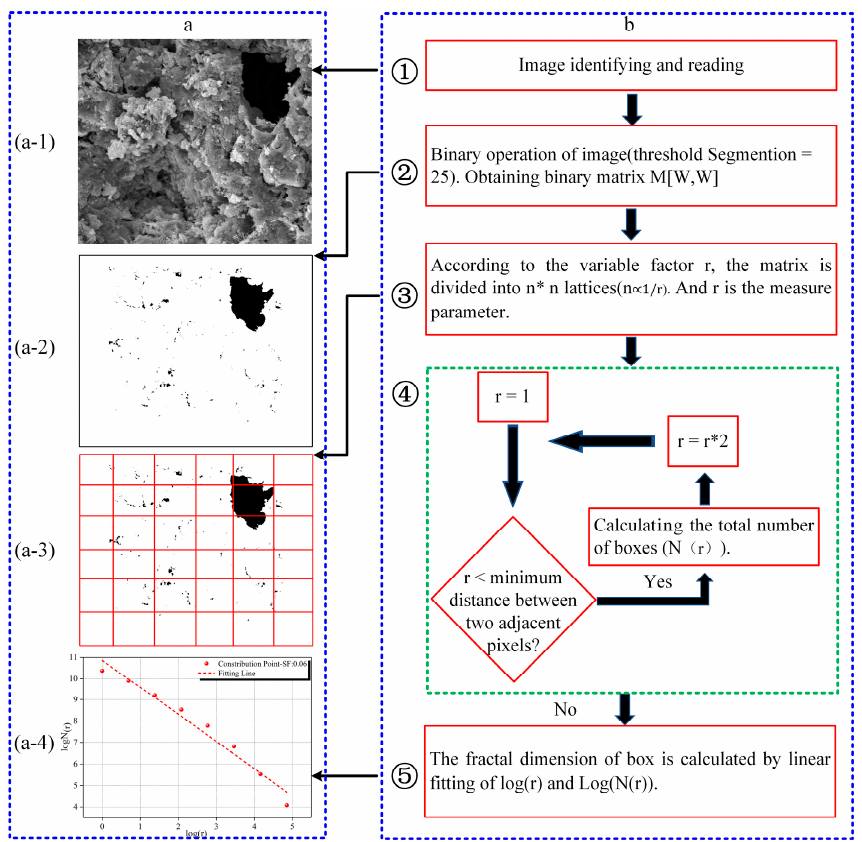
Figure 3. Box fractal dimension calculating. ( a ) is a schematic diagram of calculating fractal dimension. ( b ) is the calculation process of fractal dimension.